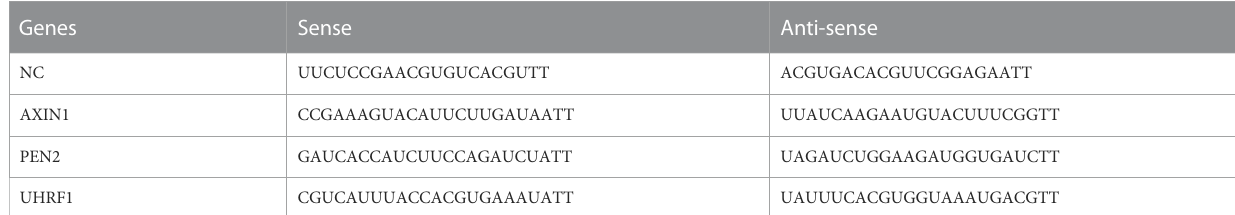
TABLE 1 Sequences of siRNAs used in human HCT-116 cells.